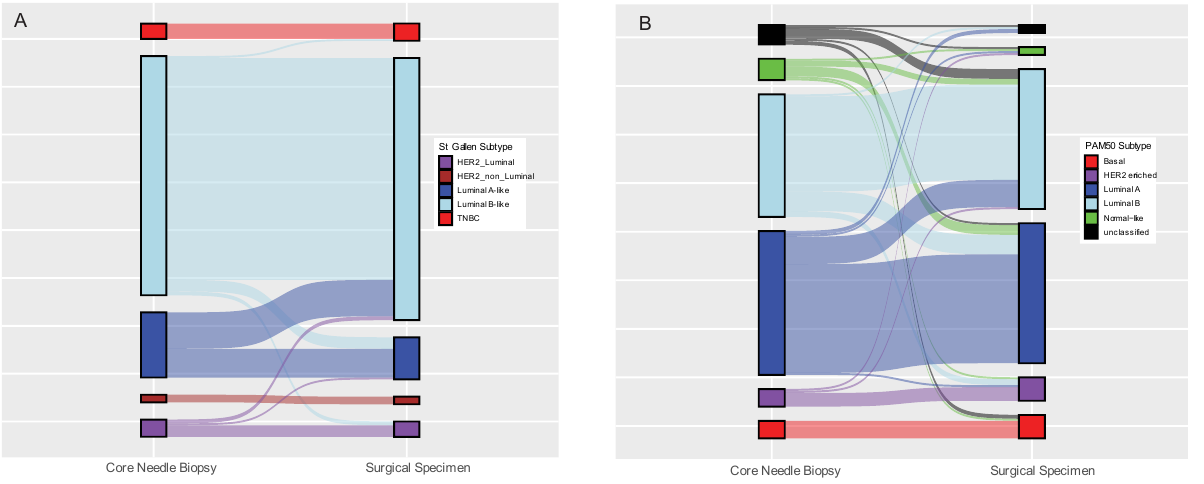
Figure 2. Concordance of St Gallen subtypes ( A ) and PAM50 subtypes ( B ) between paired core-needle biopsies and surgical specimens. Table 2. Concordance of biomarker status between paired preoperative CNB and surgical specimen assessed using IHC and GEX,